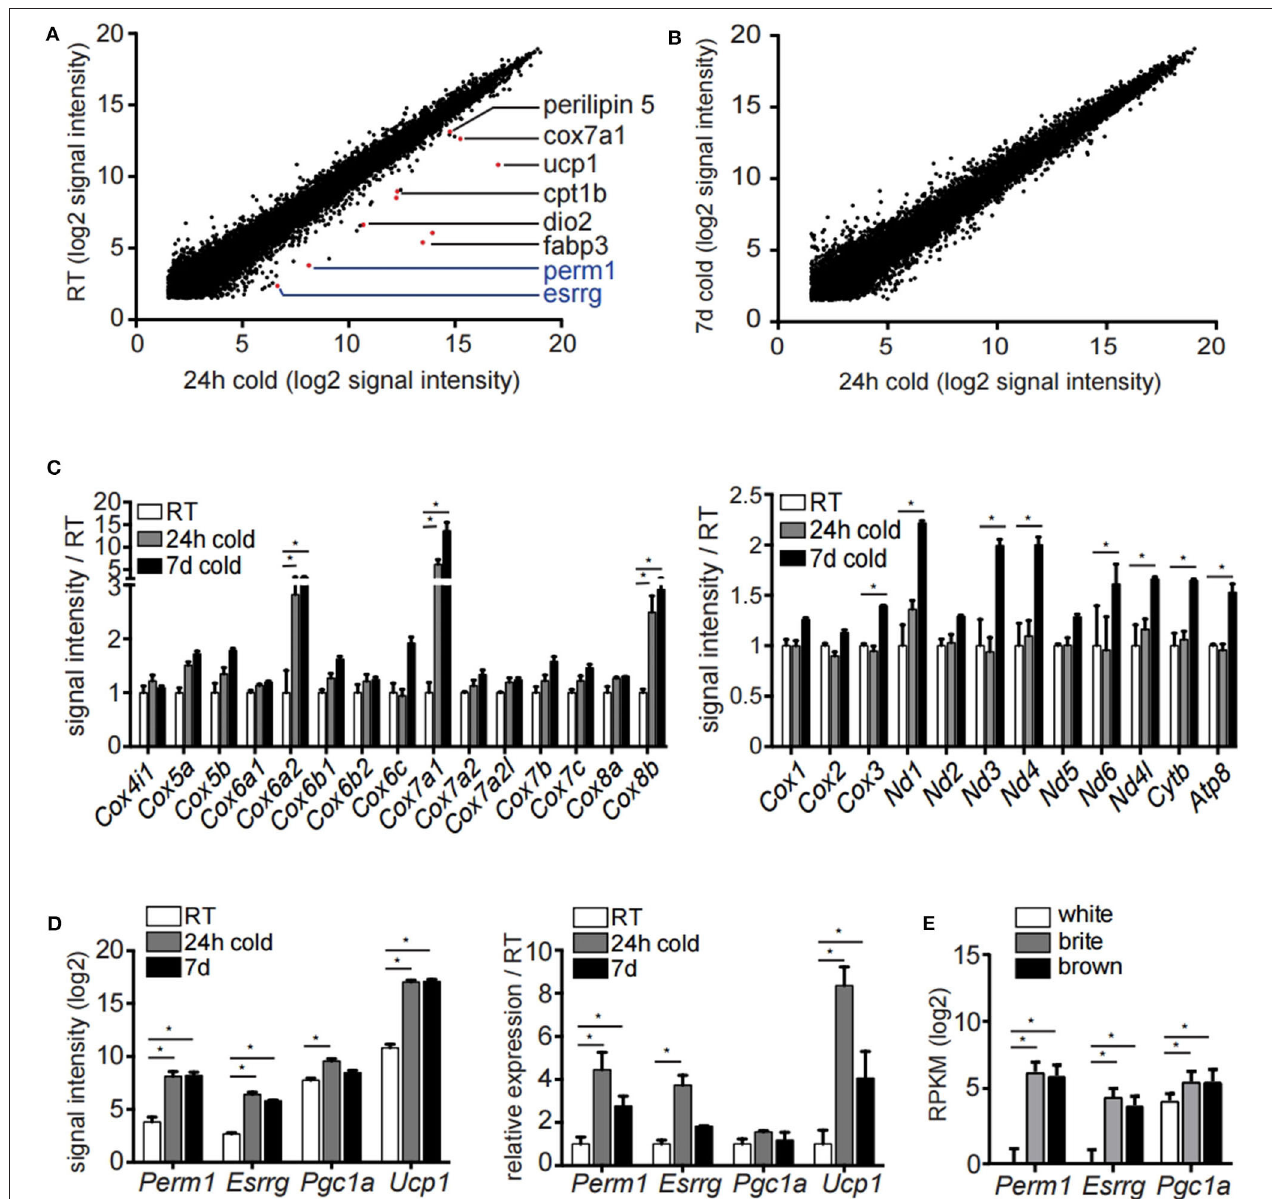
FIGURE 1 | Microarray analysis of inguinal white adipocytes during cold exposure. (A,B) Signal intensities (log2) of all probes measured of the extracted RNA of the adipocyte fraction of ingWA comparing 24h cold exposure and room temperature (A) or 24h and 7 days cold exposure (B) . Depicted in red are browning markers upregulated after cold treatment. (C) Signal intensity of specific nuclear encoded mitochondrial genes for OXPHOS complex IV (left) and all mitochondrial encoded genes (right) in room temperature, after 24h and 7 days of cold exposure. Data are presented as microarray signal intensities relative to room temperature as mean with SEM ( n = 3–5). (D) Expression of target genes Perm1 , Esrrg , Pgc1 α , and Ucp1 in room temperature, after 24h and 7 days of cold exposure shown in the microarray (left) and in an independent cohort of mice via qRT-PCR (right). Data are presented as signal intensities (log2) or relative expression (ddCt) compared to room temperature, respectively, as mean with SEM ( n = 3-5 per cohort). (E) Expression of target genes Perm1 , Esrrg, and Pgc1 α in FACS sorted mature adipocytes according to GFP expression under control of the Ucp1 promoter. Data are presented as mean RPKM (log2) with SD ( n = 10 per cell type). Statistical testing ( t -test) was performed between room temperature condition and cold housing for 24h or 7 days, respectively, or between sorted white adipocytes and brite or brown adipocytes. A statistically significant result, meaning p -value < 0.05, is indicated with an asterisk